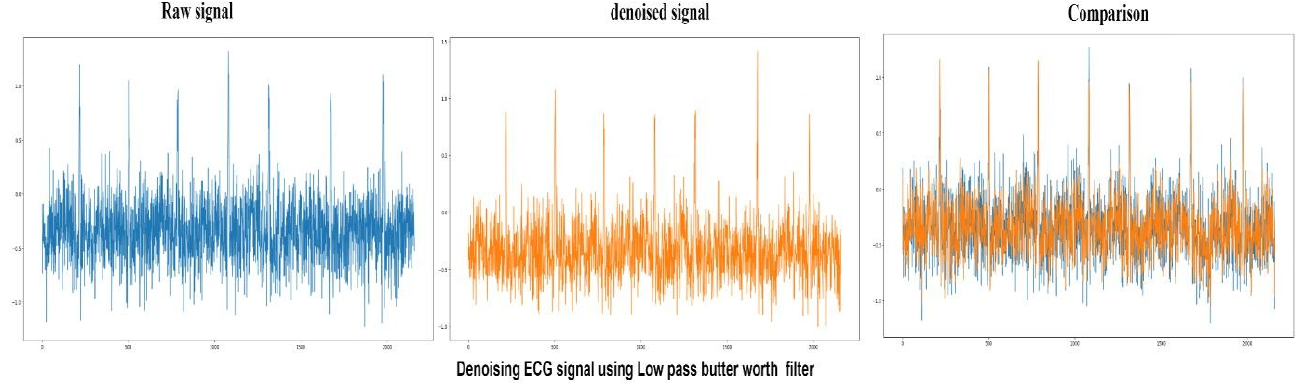
Figure 11. Raw ECG signal (Blue) denoising using low-pass Butterworth filter compares denoised (Orange) and raw signals.